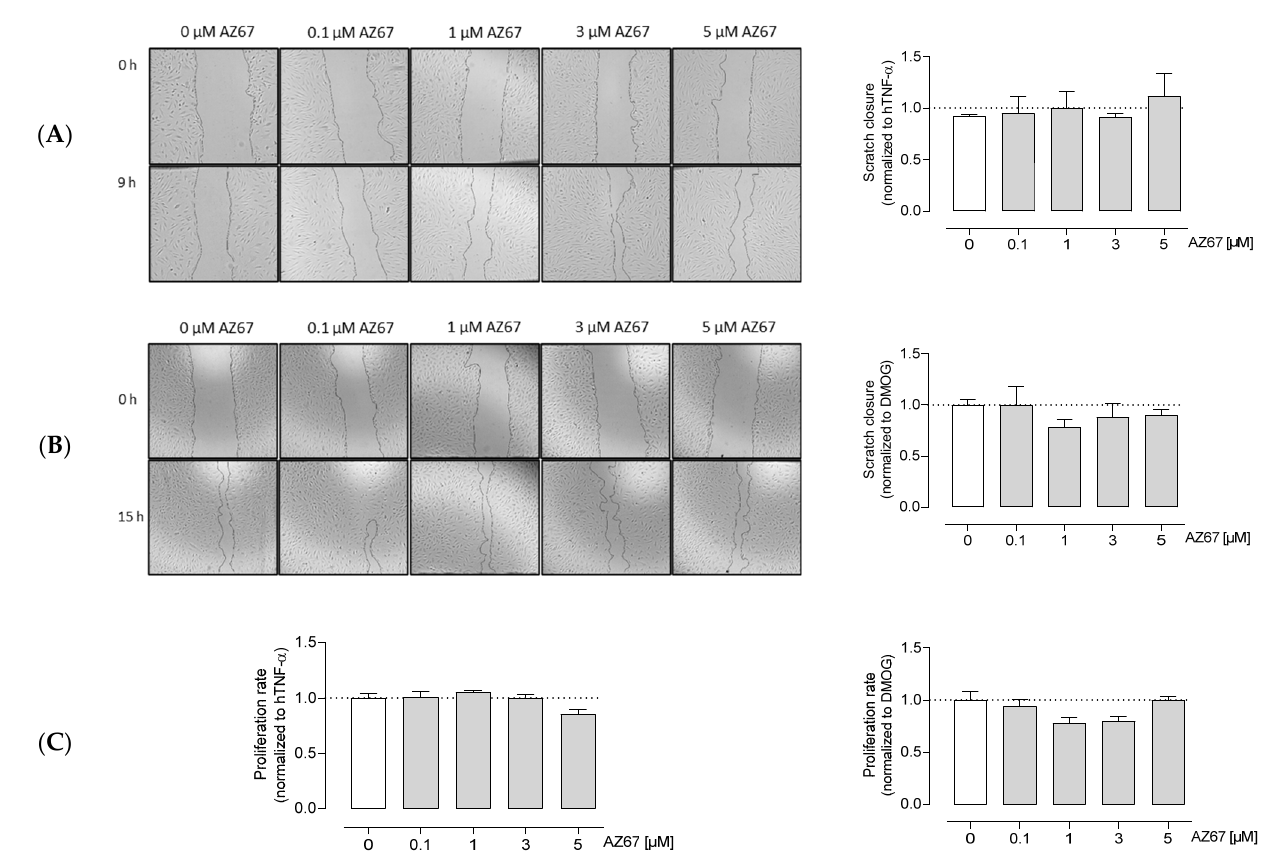
Figure 4. AZ67 does not inhibit the migration and proliferation of HAOEC. Cells were pre-treated with 20 ng/mL TNF-alpha ( A ), or 1 mM DMOG ( B ) for 24 h. Each well was marked below the plate surface by drawing a vertical line. A scratch intercepting the marked line was done in each well, cells were rinsed and medium containing different concentrations of AZ67 (0.1, 1, 3, 5 µM) together with 20 ng/mL hTNF- α , or 1 mM DMOG was added. The wound area was measured at 0 and 9 h (for TNF- α treated), and 15 h (for DMOG treated) and migration was quantified. N = 3, p > 0.05 (one-way ANOVA). ( C ) HAOEC were stimulated with 20 ng/mL hTNF- α ( left ), or 1 mM DMOG ( right ) and treated with AZ67 at different concentrations (0.1, 1, 3, 5 µM). After 24 h of incubation time, WST-1 reagent was added to all wells and incubated for an additional 4 h. WST-1 cleavage product was measured using a microplate reader. N = 4, p > 0.05 (one-way ANOVA).